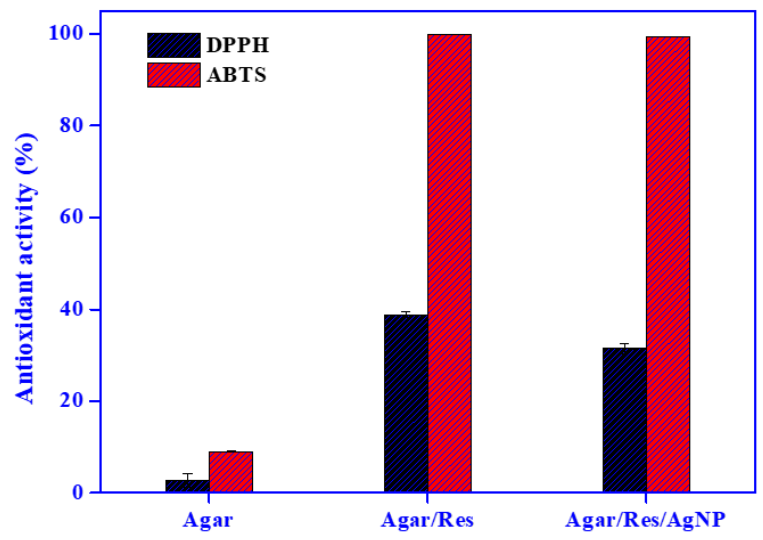
Figure 5. Antioxidant activity of the agar-based composite films determined by the DPPH and ABTS methods.